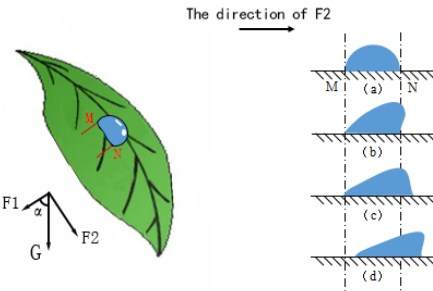
Figure 2. Schematic diagram of individual droplet deposition states; (a) and (b) uniform; (c)